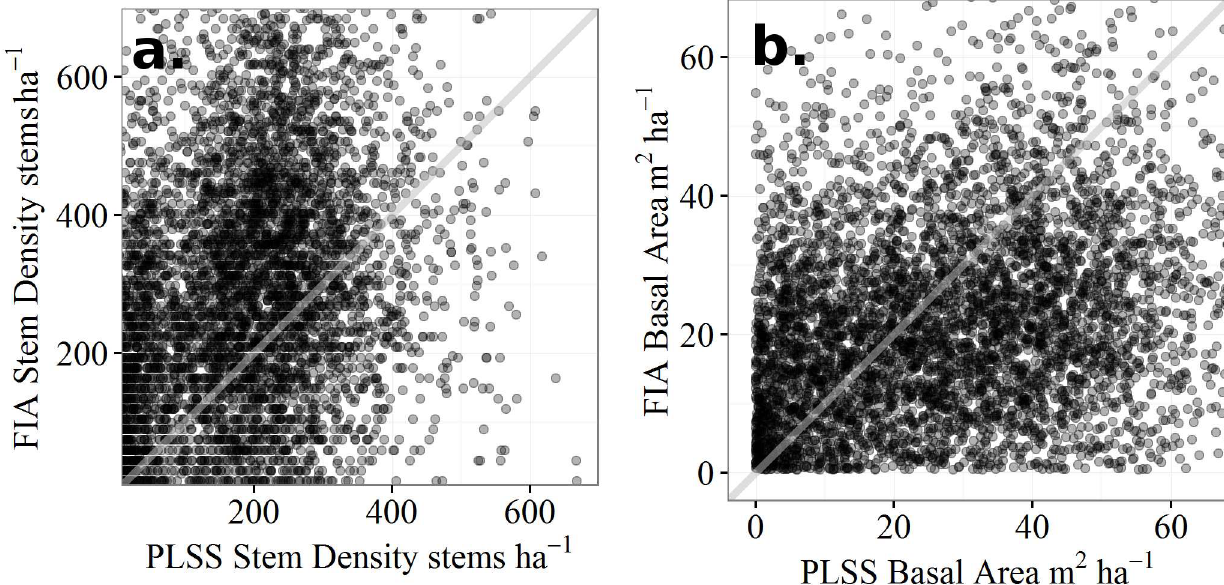
Fig 7. PLSS to FIA comparisons for stem density and basal area. Scatter plots of the relationshipbetween(a) averagestem density and (b) total basal area in the PLSS and FIA datasets. Stem density tends to be higherin the FIA, but total basal area tends to be higherin the PLSS. A 1:1 line has been added to the panels to indicateequality.